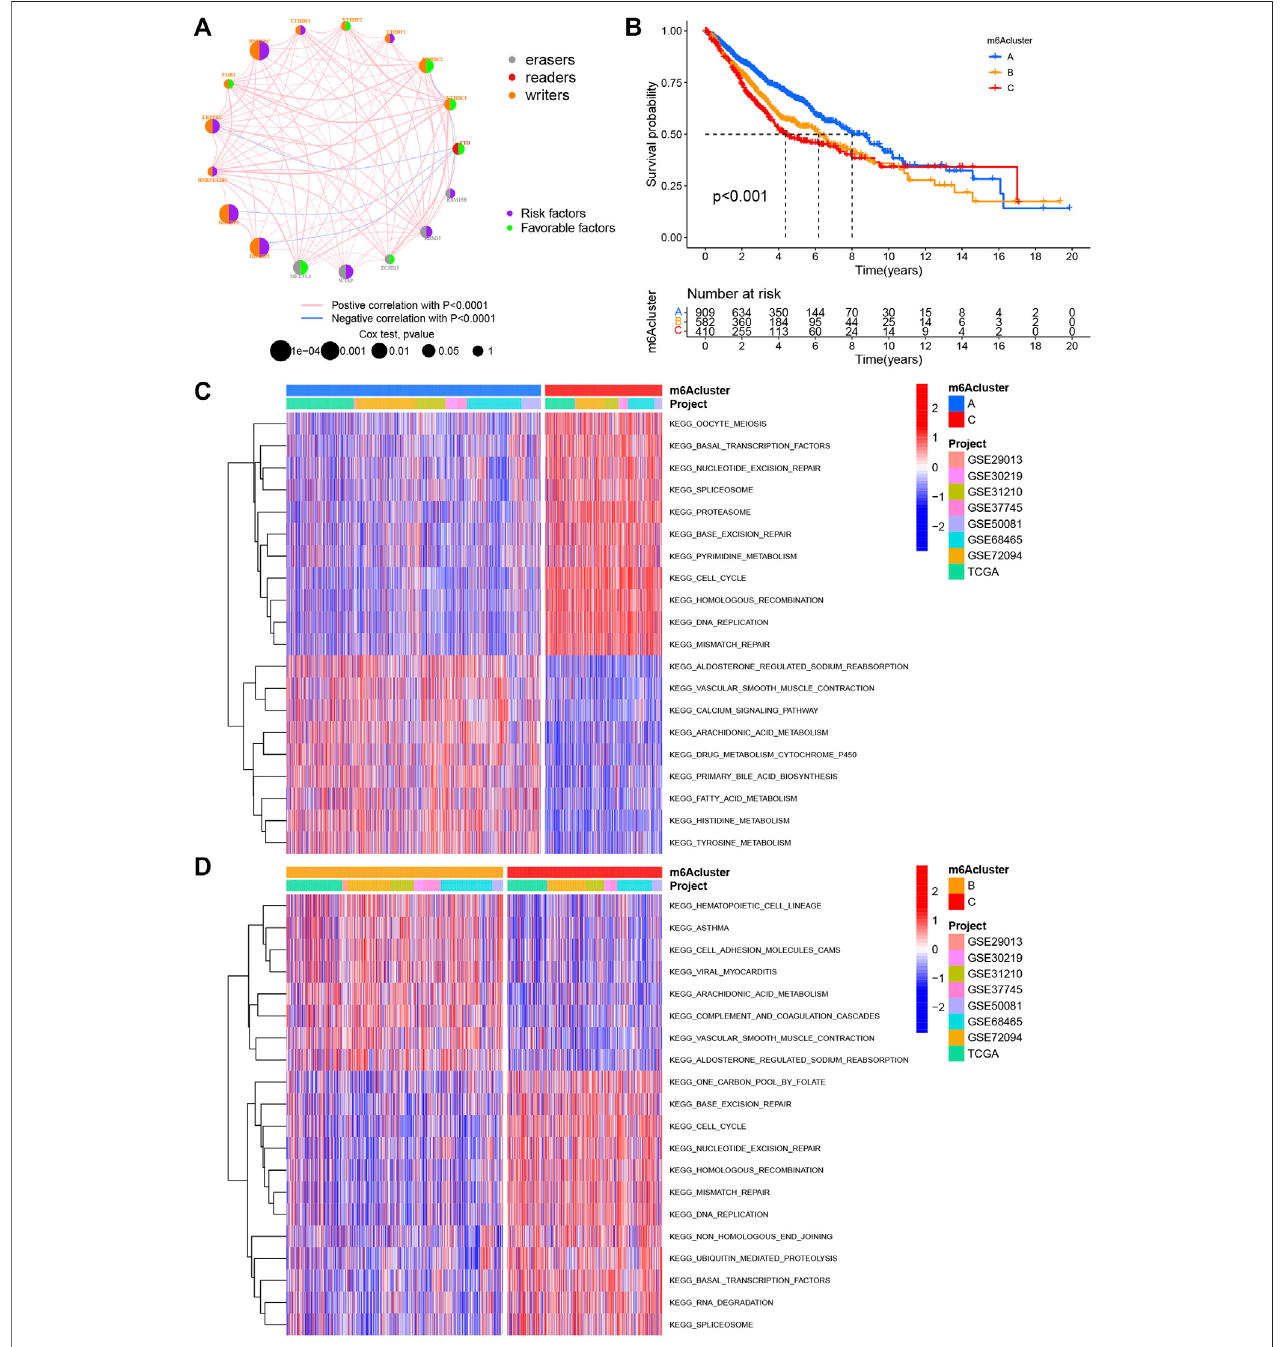
FIGURE 2 | m6A methylation modi fi cation pattern and biological characteristics of each pattern. (A) Interaction of m6A regulators in LUAD. The circle size representstheimpactofeachregulatoryfactoronprognosis,andtherangeofcalculatedvaluebylog-ranktestwas p < 0.0001, p < 0.001, p < 0.01, p < 0.05,and p < 1. Lefthalfofthecircle:purplerepresentsprognosticriskfactorsandgreenrepresentsprognosticfavorablefactors.Righthalfofthecircle:thetypesofm6Aregulators.The line connecting regulatory factors represents the interaction between regulatory factors, and the thickness represents the correlation intensity between regulatory factors, showing a negative association with blue and a positive association with pink. (B) Survival analysis based on three m6A patterns in 1901 patients from seven GEO cohorts (GSE30219, GSE31210, GSE29013, GSE37745, GSE68465, GSE50081, and GSE72094) and one TCGA – LUAD cohort, including 909 cases in m6Acluster A, 582 in m6Acluster B, and 410 in m6Acluster C. Kaplan – Meier curves with log-rank p value less than 0.001 show signi fi cant survival differencesin survival rates between the three m6A modi fi cation modes. The overall survival of m6Acluster B was signi fi cantly better than that of the other two m6Aclusters. (C,D) Activation stateofbiologicalpathwaysindifferentm6Amodi fi cationpatternsasshownbyGSVAenrichmentanalysis.Thebiologicalprocesseswerevisualizedbyusingheatmaps, with red representing activated pathways and blue representing inhibited pathways. LUAD queue was used as sample annotations. C: m6Acluster C vs. m6Acluster A; D: m6Acluster C vs. m6Acluster B.